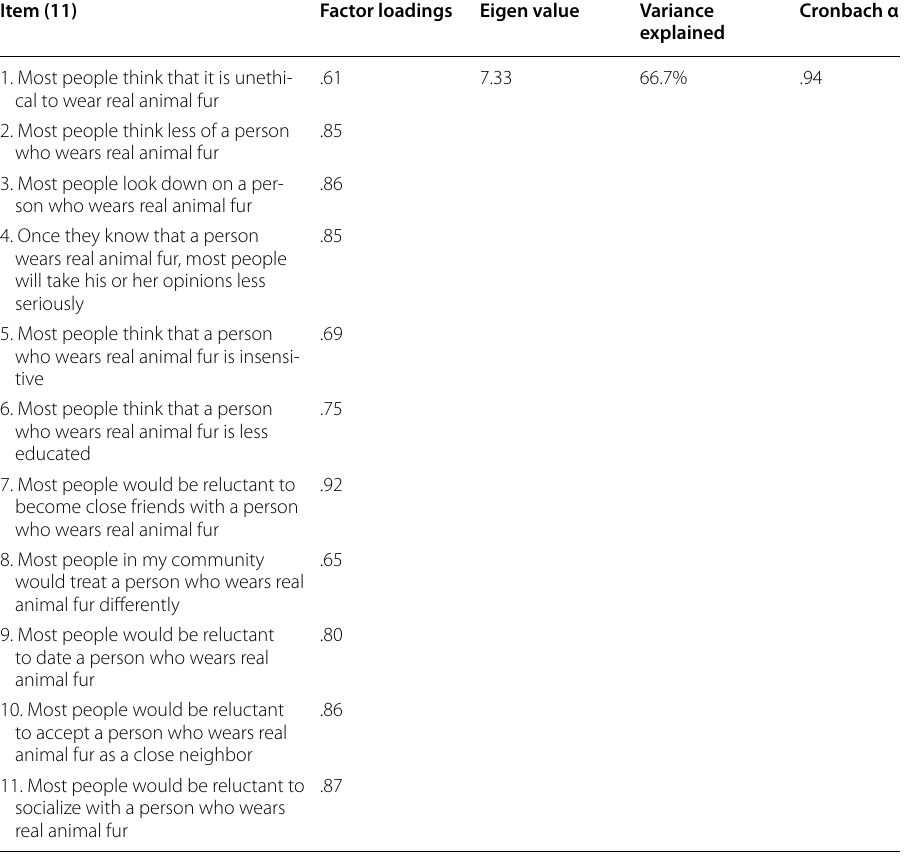
Table 1 Results of EFA: perceived stigma scale Item